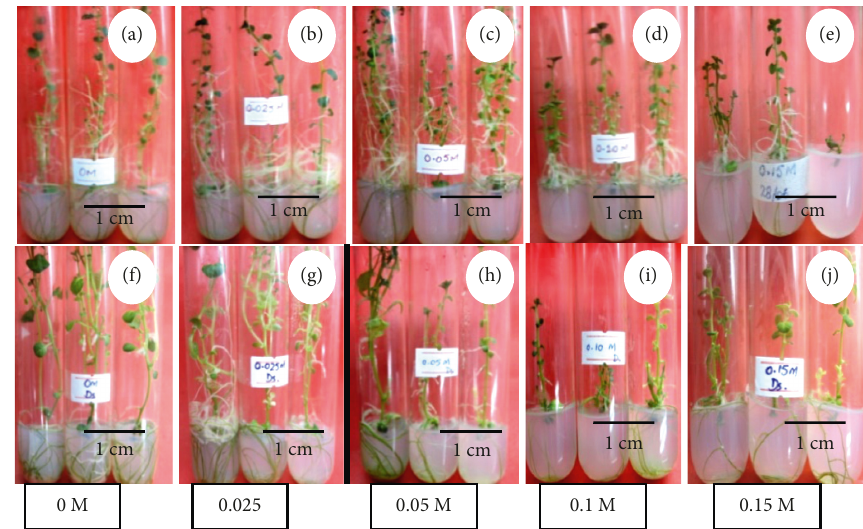
Figure 3: Growth of Cardinal (a)–(e) and Desiree (f)–(j) at different mannitol concentrations. Scale bar (a)–(j) �